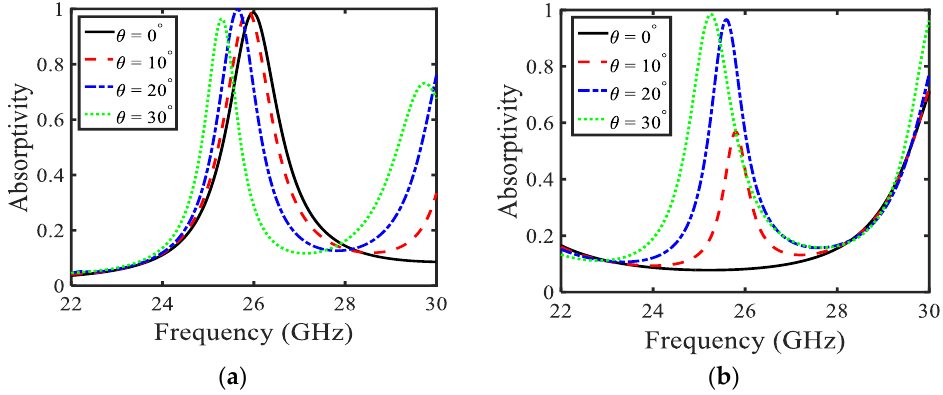
Figure 2. Absorption of the proposed MA keeping substrate thickness t = 0.8 mm ( a ) TE polarization and ( b ) TM polarization.